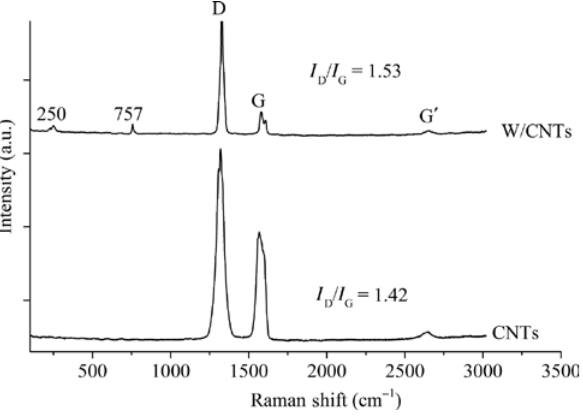
Figure 6: Raman spectra of CNTs and W/CNT.